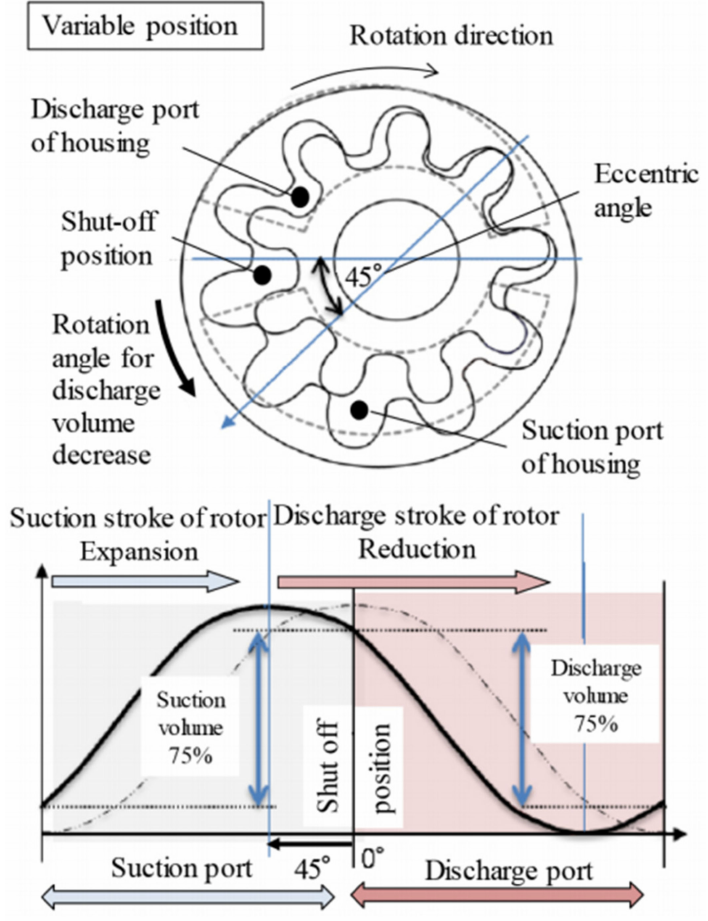
Figure 10. F-VDOP pumping process at variable discharge position